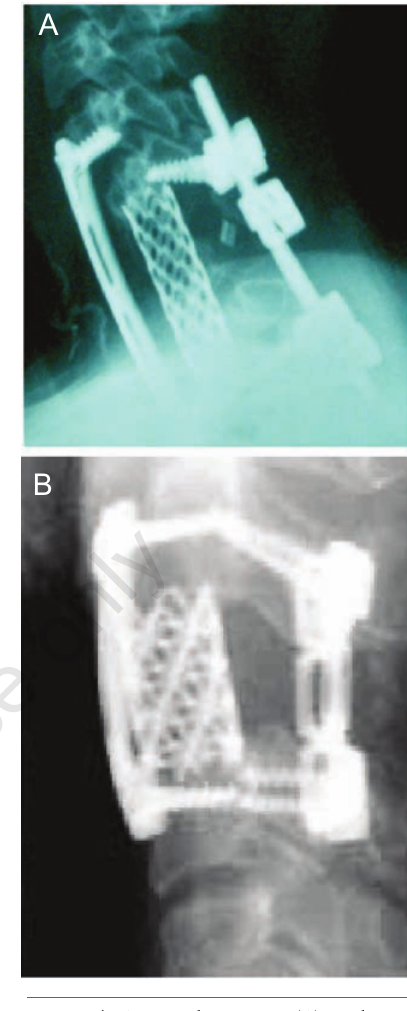
Figure 4. A staged anterior (A) and pos - terior (B) spinal fixation after corpectomy and total resection of the spinal tumor from front and back.